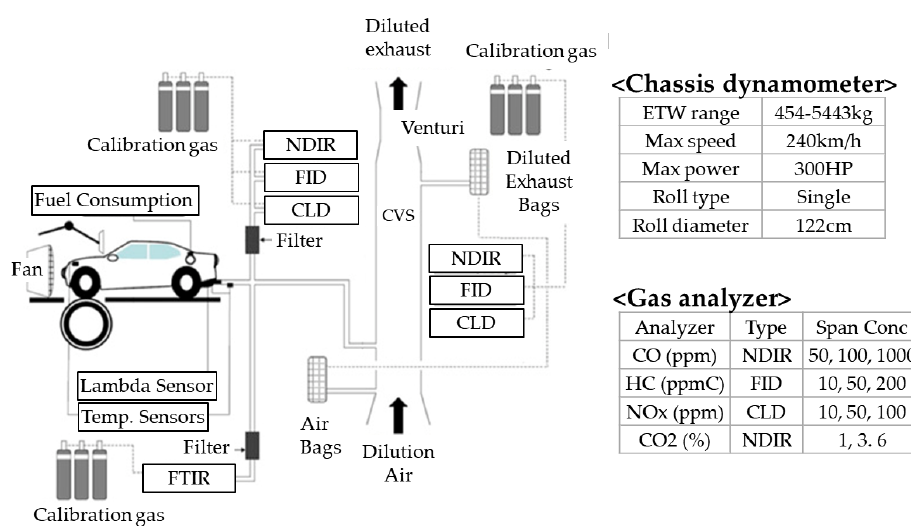
Figure 7. Schematic diagram of chassis dynamometer and emission measurement system.